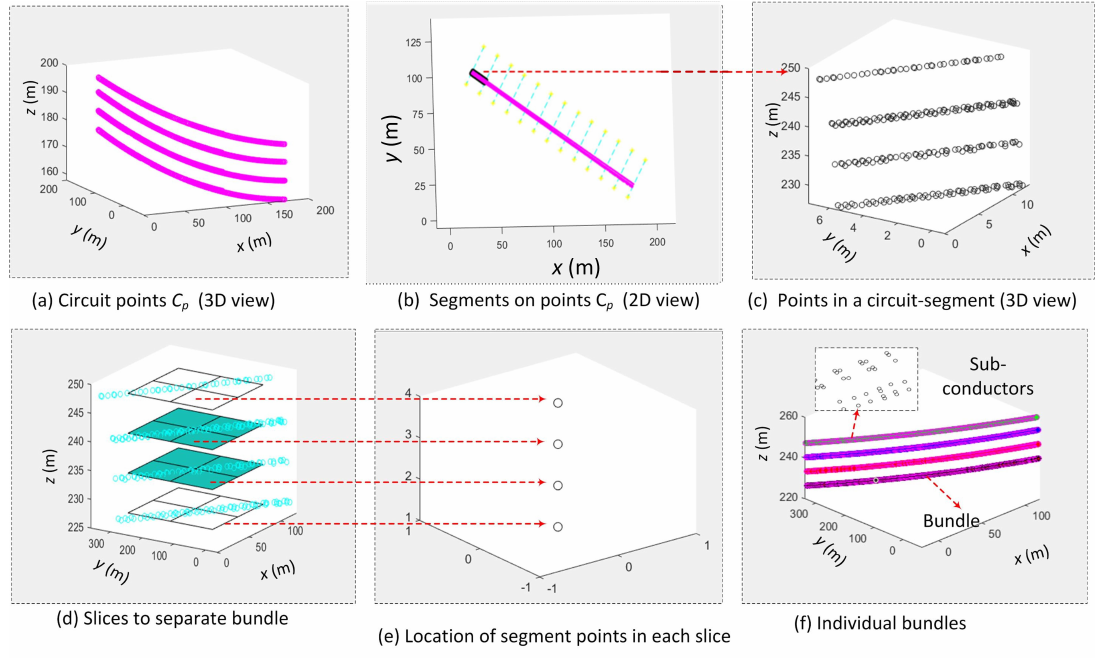
Figure 4. Detection and extraction of bundle points. In panels ( a – d , f ) the origin (0, 0) represents (5.155 × 10 5 , 6.92176 × 10 6